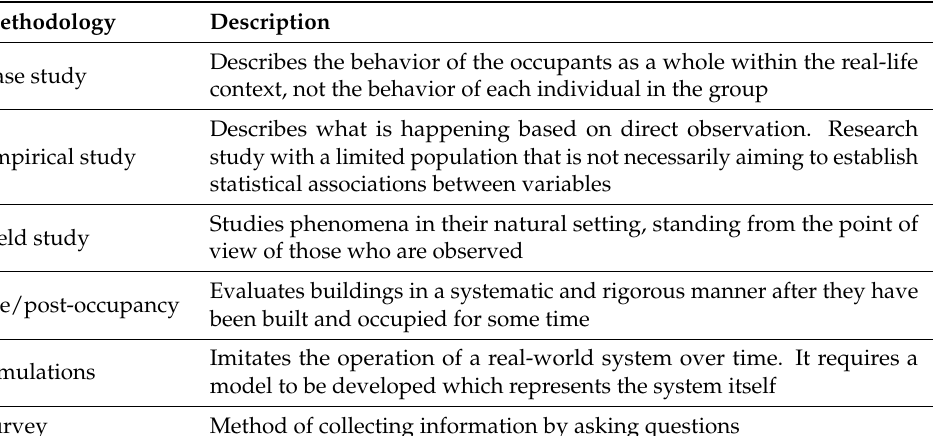
Table 2. Classification of methodologies by